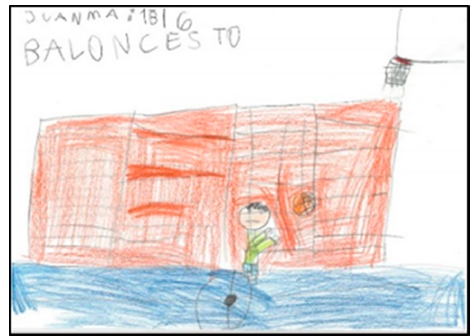
Figure 17. Number of figures present. Isabel. 1°B.